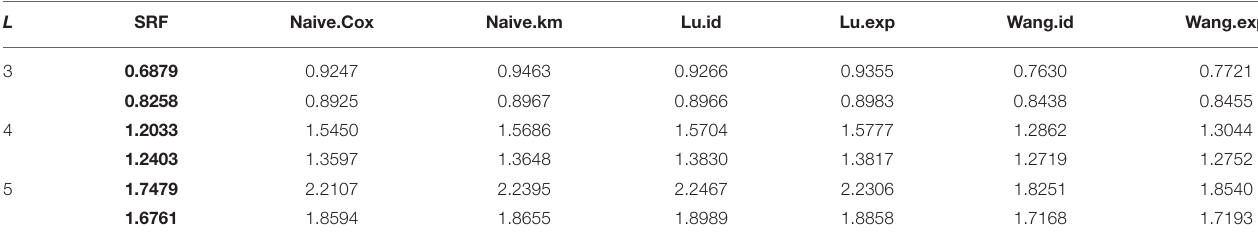
TABLE 7 | Performance of the proposed random forest estimator compared with other methods for L = 3,4,5. L SRF Naive.Cox